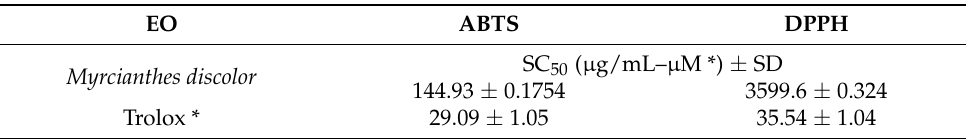
Table 4. Antioxidant activity of the essential oil of Myrcianthes discolor